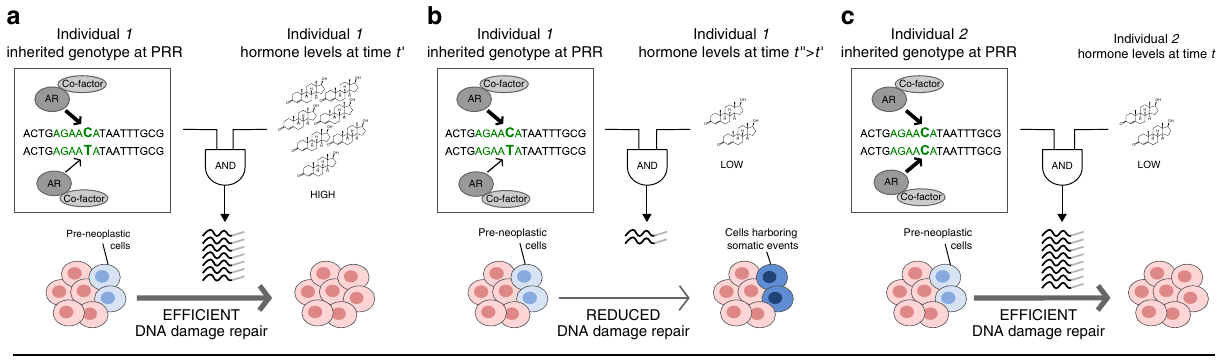
Fig. 4 Two-variable model of genotype – environment interaction study. Three combinations of individual ’ s genotypes (ancestral allele, cytosine) at a polymorphic regulatory region (PRR) and hormone levels (high, low) are represented as examples of the study rationale. a Heterozygous genotype of Individual 1 and high hormone levels maintain DNA damage repair ef fi ciency; b in the presence of low hormone levels for the same individual, reduced transcription of DNA repair genes is expected, facilitating the emergence of early somatic events; c low hormone levels do not impair DNA damage repair ef fi ciency of Individual 2 who inherited ancestral homozygous genotype at the site. Within sequences, green nucleotides indicate AR half motif; bold identi fi es the SNP locus in the regulatory region [C/T]. The described interaction is not relevant to hormone insensitive tissues. Based on the speci fi c study results, we postulate that in case of the rs1376350 locus AR mediates repression activity partially through the negative regulation of CEBPB and its recruitment to the polymorphic regulatory locus where the minor allele demonstrates higher AR af fi